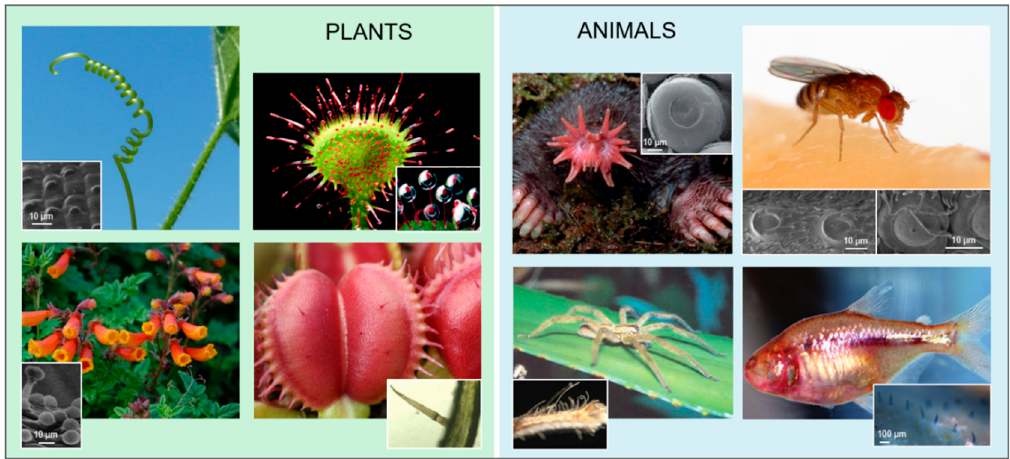
Figure 2 . Overview of examples of specialized mechanical sensory organs with significant biomechanical aspects in nature. The different sensor type morphologies are encountered in the plant and animal kingdoms. Plants : (top left) Bryonia dioica Jacq. tendril (A. Moro, Department of Life Sciences, University of Trieste, CC BY-SA 4.0 [37]), (inset) tactile bleps on tendril (reprinted by permission from Springer, [30]); (top right) Drosera rotundifolia , (inset) close up of tentacle tips (photos by Barry Rice, http://www.sarracenia.com); (bottom left) Eccremocarpus scaber (CC BY-NC-ND 2.0 [38]), (inset) tactile papillae on tendril (reprinted from [32] by permission of John Wiley & Sons, Inc.); (bottom right) Dionaea muscipula (reproduced with permission from FlyTrapCare.com), (inset) trigger hair (photo by Martin Brunner, CC BY-SA 2.5 [39]). Animals : (top left) star-nosed mole, (inset) Eimer’s organ on star (adapted from [29], Copyright 2012, with permission from Elsevier); (top right) Drosophila melanogaster (photo by Sanjay Acharya, CC BY-SA 4.0 [37]), (inset) campaniform sensilla on halteres (adapted from [33], Copyright 2017, with permission from Elsevier); (bottom left) Cupiennius salei (reprinted by permission from Springer, [34]), (inset) spider hair sensilla (adapted from [35], Copyright 2004, with permission from Elsevier); (bottom right) Astyanax fasciatus , (inset) cupulae of neuromasts on the lateral line (reproduced from [36] with permission from The Royal Society of Chemistry).